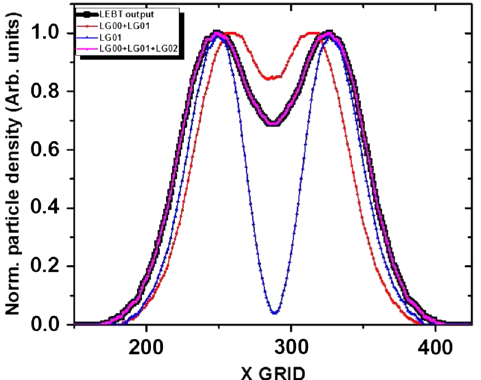
FIG. 3. Line-out of the horizontal density distribution of the HOMB, along with fits to various higher-order Laguarre- Gauss